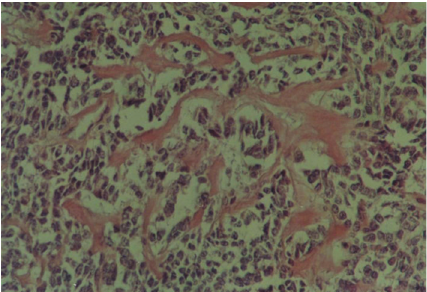
Figure 4: Benign-Appearing bone trabeculae interspersed with lymphoid tissue, hematoxylin, and eosin, ×